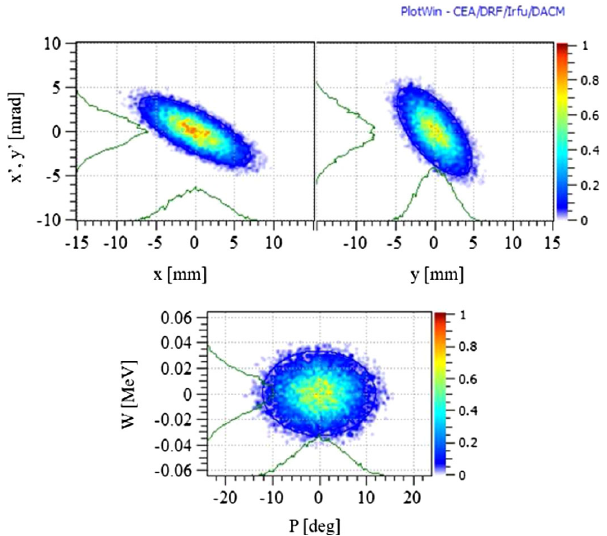
FIG. 3. Distribution at the entrance to the first DTL cavity for a proton beam of 2.0 mA and k 0 ;t ¼ 50 °, k 0 ;z ¼ 90 °. The rms emittances are 3 . 24 = 3 . 24 = 10 . 8 mm mrad in the horizontal/verti- cal/longitudinal plane.